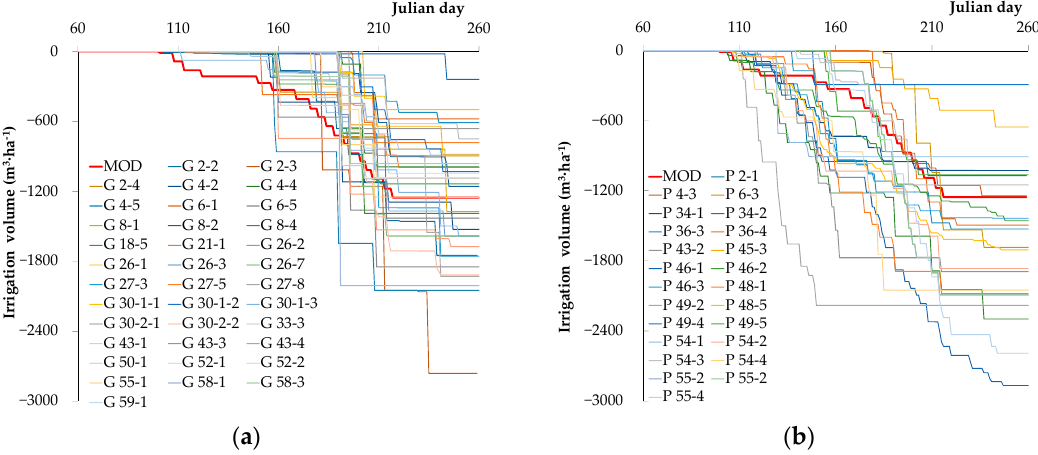
Figure 6. Cumulative irrigation actually supplied by farmers and calculated by the model (the bold red line) for grape ( a ) and peach ( b ).